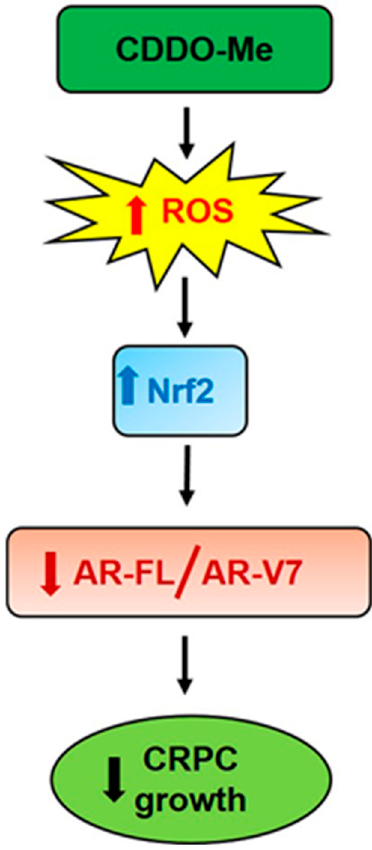
Figure 7. Mechanism of AR suppressive actions of CDDO-Me in PC cells. Exposure to Bardoxolone-methyl (CDDO-Me) causes a transient induction of reactive oxygen species (ROS) which in turn activates Nrf2 protein levels. Ultimately, this antioxidant transcription factor decreases oxidative stress and the aggressive properties of CRPC cells, e.g., growth, migration, clonogenic ability, etc. Both Nrf2 and ROS may be directly involved in suppressing AR expression (both at the gene and protein levels). Decreased AR signaling (via AR-FL and AR-V7) by CDDO-Me inhibits the growth of CRPC cells and can augment the anticancer efficacy of approved drugs like enzalutamide (ENZ).